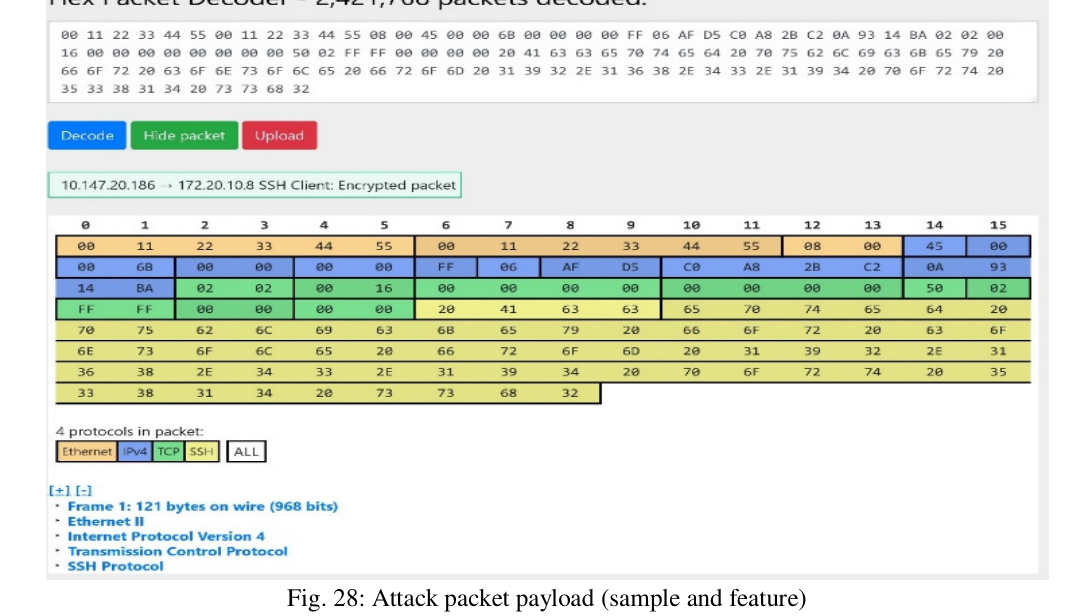
Fig. 28: Attack packet payload (sample and